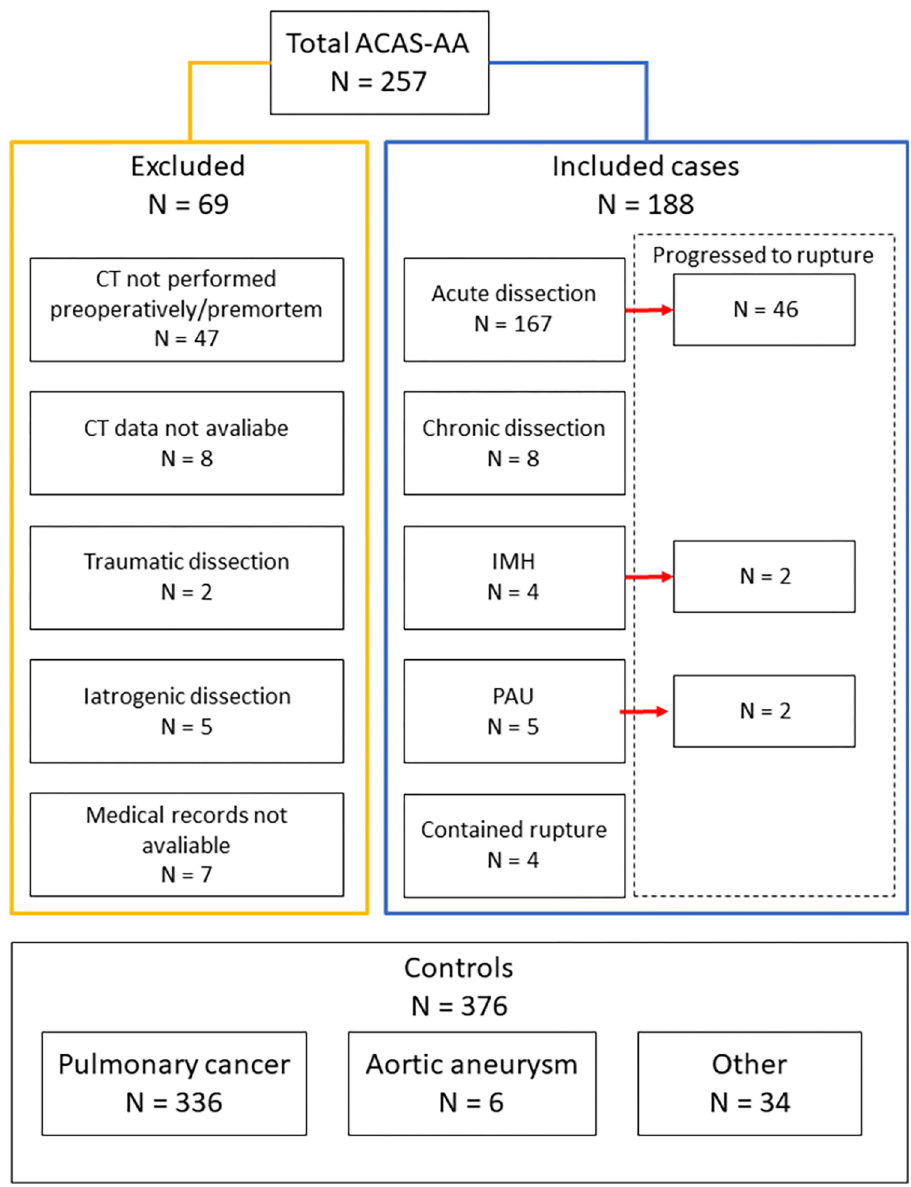
Fig 2. Inclusion and exclusion of cases and controls. n = number, ASAC-AA = Acute and chronic aortic syndromes of the ascending aorta, CT = computer-tomography scan, IMH = intramural hematoma, PAU = penetrating aortic ulcer. Other = patients with recurrent spontaneous pneumothorax or benign pulmonary